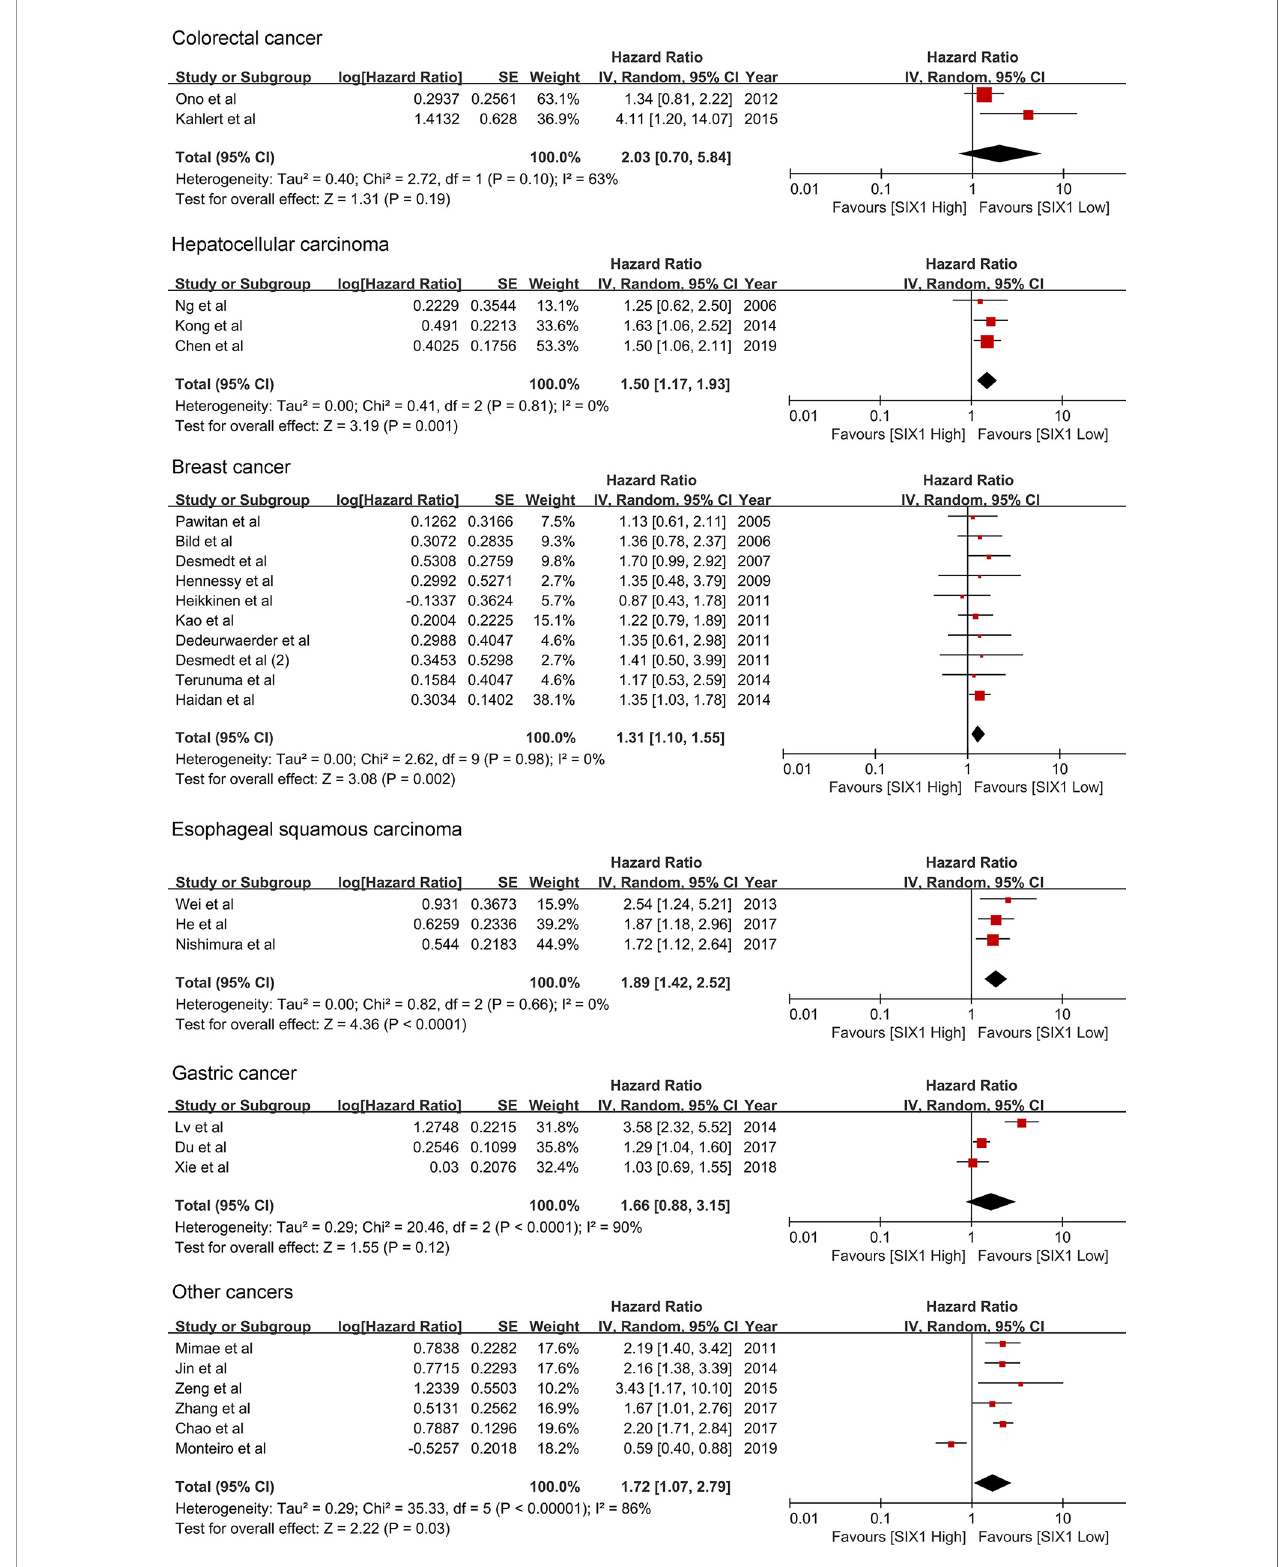
FIGURE 3 | Forest plot of subgroup analysis by cancer type and